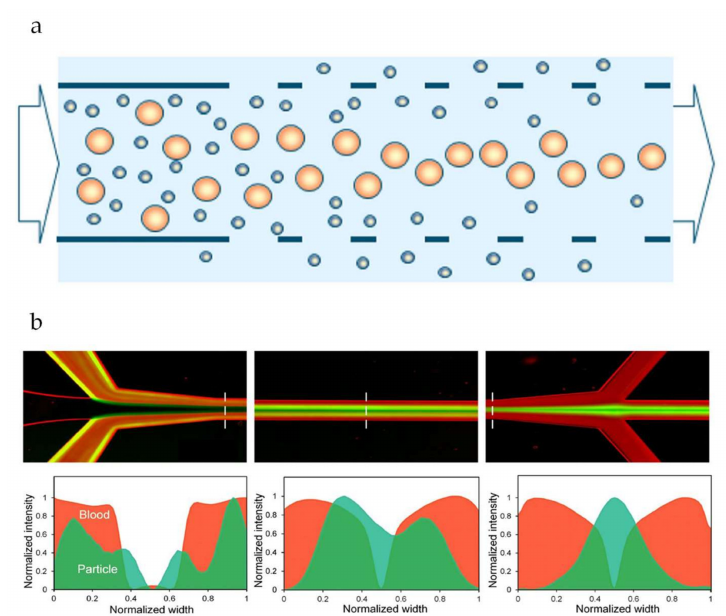
Figure 7. ( a ) Schematic representation of shear induced di ff usion separation in a porous channel [14]. ( b ) Top: Merged images (fluorescent + inverted bright field) demonstrating the concept of shear induced di ff usion separation of a mixture of blood (red) and PS particles (green). Bottom: Intensity profiles of blood and particle streams across the dashed lines present on the merged microscopy images